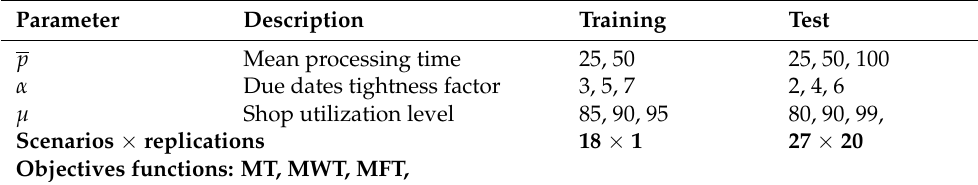
Table 1. Scenarios used in simulations for training and